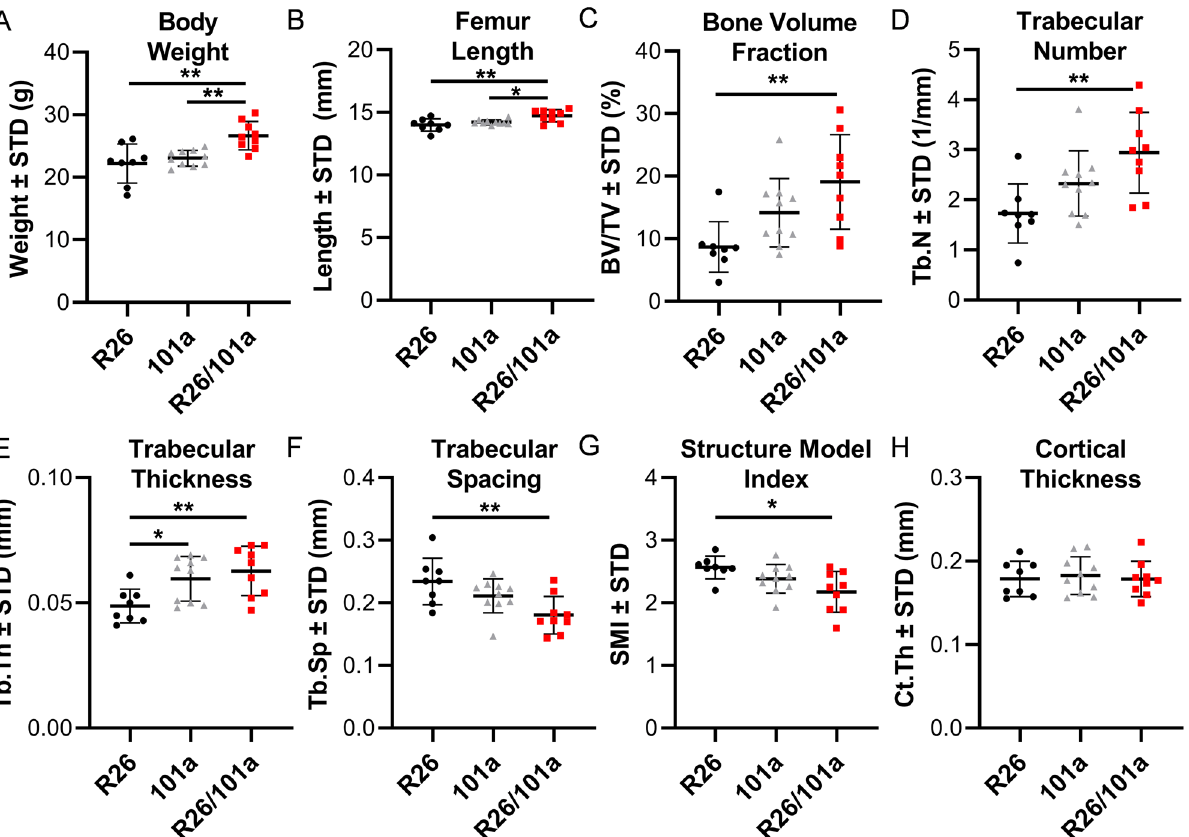
Figure 6. miR-101a over-expression enhances trabecular bone mass in male mice. R26 control, miR-101 control, and miR-101a over-expressing (R26/101) male mice were treated with doxycycline from inception to sacrifice (8 weeks). The figure depicts body weight ( A ), femur length ( B ), trabecular bone parameters ( C–G ), and cortical thickness ( H ) as assessed by µCT (n = 8 to 10, mean ± STD). *p < 0.05 and **p < Overexpression of miR101a in male mice increases femoral length with a commensurate increase in body weight when compared to both R26 and miR-101a control mice (Fig. 6A,B). Female mice exhibit a similar overall phenotype with miR-101a dependent changes in weight and femoral length phenotype, except that the body weight of female miR-101a over-expressing mice was only statistically different from miR-101a controls, but not from R26 controls (Fig. 7A,B). Skeletal analyses using μCT reveals increases in trabecular bone volume fraction, trabecular number, and trabecular thickness, while a decrease in trabecular spacing and structure model index is observed in male miR-101a over-expressing mice when compared to R26 control mice (Fig. 6C–G). The miR-101a control mice are similar to R26 control mice (except for increased trabecular thickness), but the μCT parameters are not significantly different between miR-101a controls and miR-101a over-expressing mice. Of interest, when assessing body weight, femur length, and trabecular bone parameters, the phenotype of miR-101a control mice is consistently between R26 controls and miR-101a over-expressing mice. The latter is consistent with ‘leaky’ transcription of the transgenic cassette as noted above (see Figs. 3 and 5). Thus, the elevated expression of the miR-101a transgene in the miR-101a controls may explain the lack of statistical difference between miR-101a con- trols and miR-101a over-expressing male mice (see Fig. 5). In contrast to male mice, no differences in trabecular bone parameters measured by µCT are observed among the three groups in female mice (Fig. 7C–G). Further, overexpression of miR-101a did not alter cortical bone geometry in the femoral mid-diaphysis for either male (Fig. 6H) or female (Fig. 7H) mice. Thus, μCT results collectively indicate that inducible transgenic expression of miR-101a during post-natal skeletal development alters bone parameters. Because miR-101a control is leaky and permits a limited level of miR-101a expression even in the absence of tetracycline-dependent transcriptional activator (tTA), histomorphometric analyses were performed on femora derived from R26 control and miR-101a overexpressing mice (Suppl Fig. 2). Static histomorphometric analyses performed on cancellous bone of the distal femur showed that osteoid volume and surface covered by osteoid are significantly decreased in bones from male mice, whereas the number and surface of osteoblasts do not vary, resulting in a significant decrease in the corrected osteoid surface per osteoblast in miR-101a over-expressing male mice when compared to R26 control male mice (Fig. 8). On the other hand, osteoclast number and surface, as well as eroded surface and osteocyte density are similar between R26 control and miR-101a over-expressing male mice. However, miR-101a over-expression does not alter osteoid or osteoblastic parameters but results in a small but significant decrease in osteocyte density, and in osteoclast and eroded surface in cancellous bone of distal femurs when compared to R26 control in female mice (Fig. 9). These results do not exclude the possibility